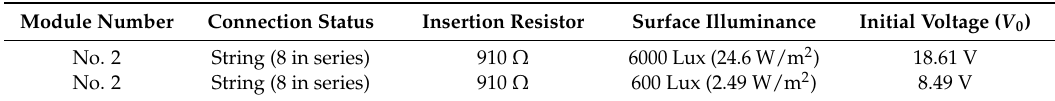
Table 2. Key parameters of comparison experiment.